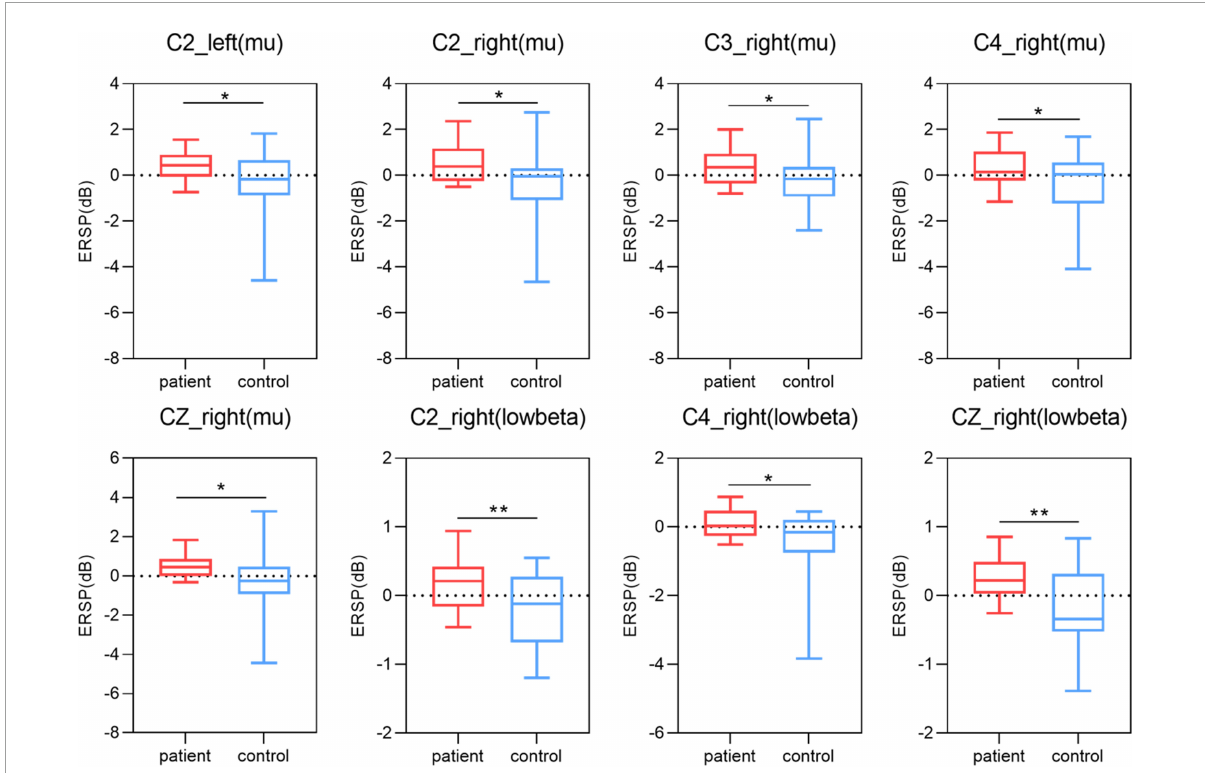
FIGURE5 Results of one-way ANOVA. Comparison of power in mu and low beta band and five channels (C3, C1, Cz, C2, C4) during two motor imagery (MI) tasks (second 0–5 s of the trial) among lower limb amputees and healthy controls. Left, left-side MI task; right, right-side MI task; * p < 0.05; ** p <